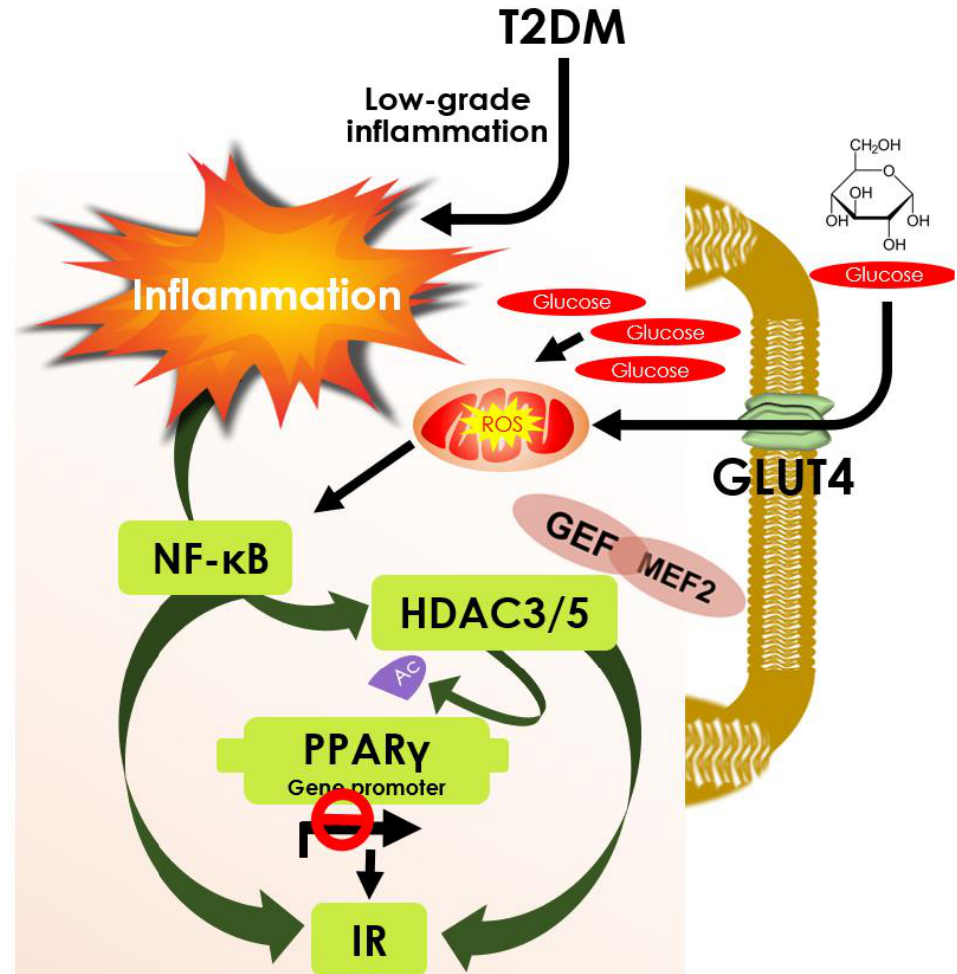
Figure 4. Schematic diagram showing the role of HDAC3 and 5 in PPARγ deacetylation and insulin resistance. Low -grade inflammation in T2DM and Glucose uptake by GLUT4 that produces ROS collectively activates NF- κB function. It modu- resistance. Low-grade inflammation in T2DM and Glucose uptake by GLUT4 that produces ROS lates HDAC3/5 to deacetylate PPARγ and inact ivate its function that contributes to insulin resistance; however, it can be collectively activates NF- κ B function. It modulates HDAC3/5 to deacetylate PPAR γ and inactivate its overcome by HDAC3/5 inhibition. GLUT4 Enhancer Factor (GEF) interaction with MEF2A and HDAC3/5 regulates function that contributes to insulin resistance; however, it can be overcome by HDAC3/5 GLUT4 promoter activity acquiring insulin resistance; however, inhibition of HDAC3/5 can increase GLUT 4 expression and prevent insulin resistance.